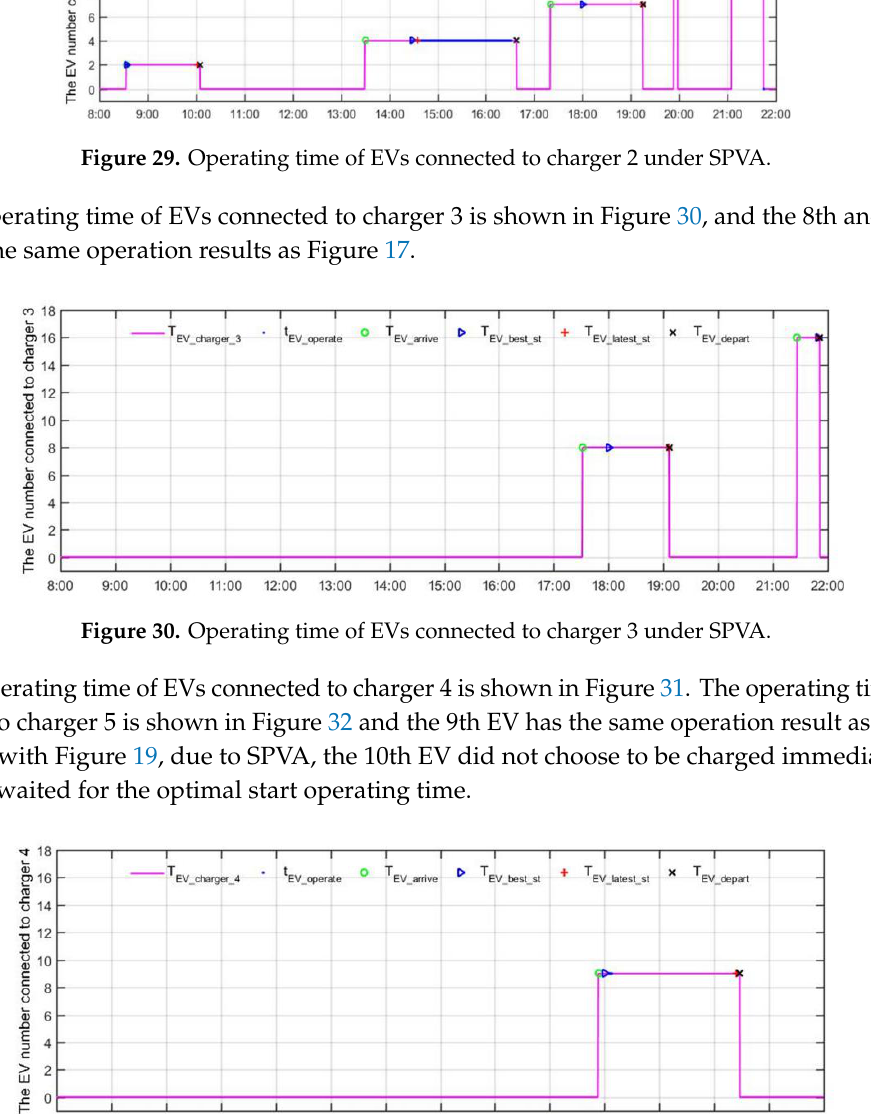
Figure 29. Operating time of EVs connected to charger 2 under SPVA.